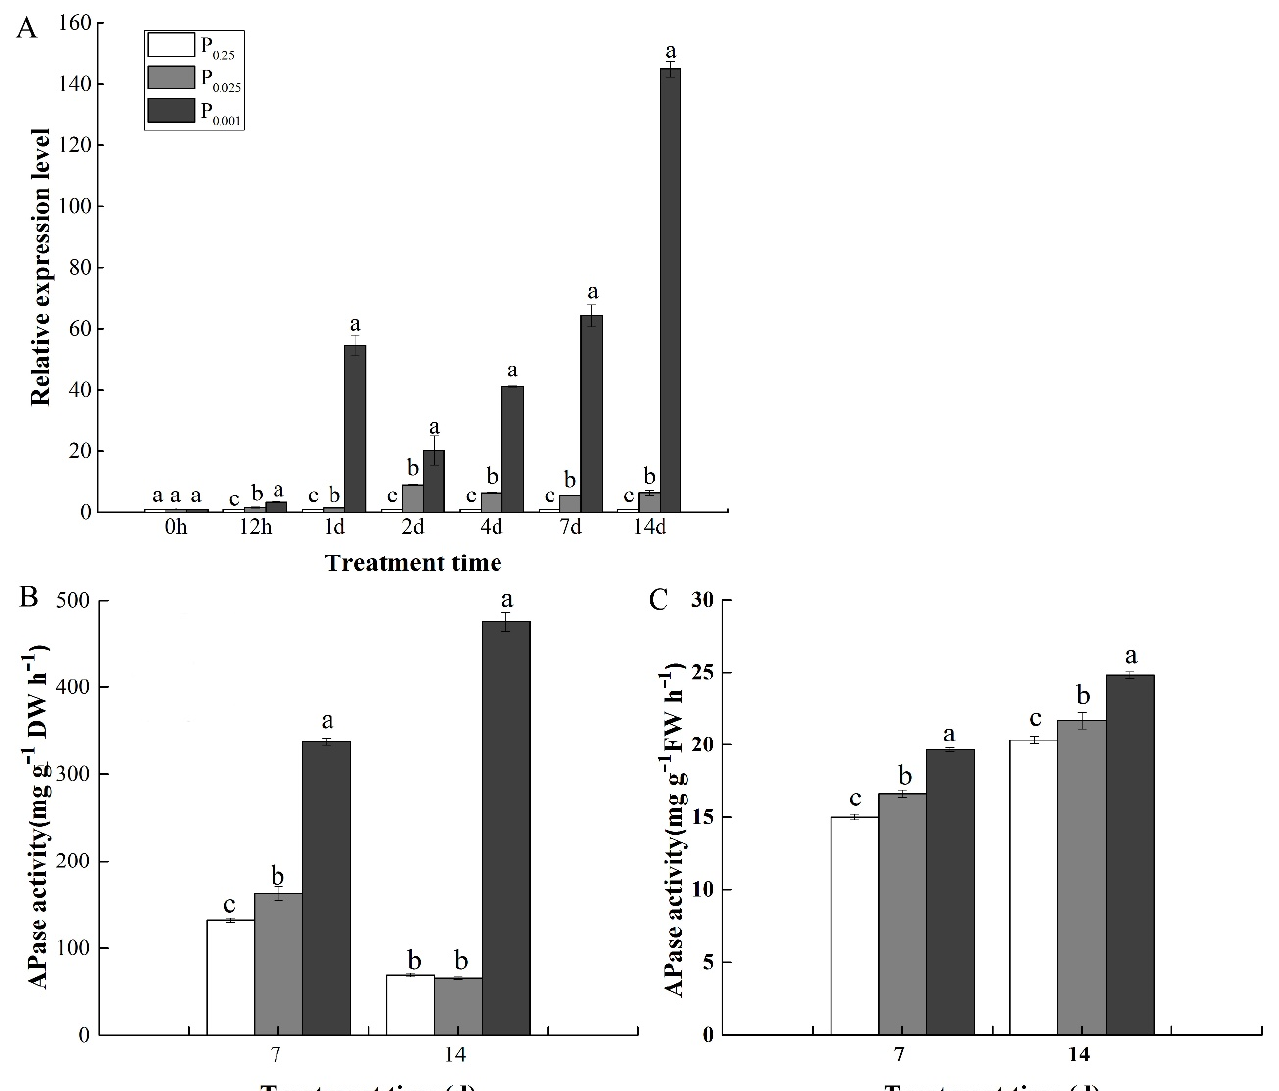
Figure 3. The APase gene expression ( A ) and activity outside (secreted by) the roots ( B ) and in root tissue ( C ) under low-Pi stress. The error bars indicate the SD ( n = 3). The lowercase letters indicate the significant differences in the parameter, at the same treatment time, among the treatments using one-way ANOVA with Tukey’s test ( p < 0.05).